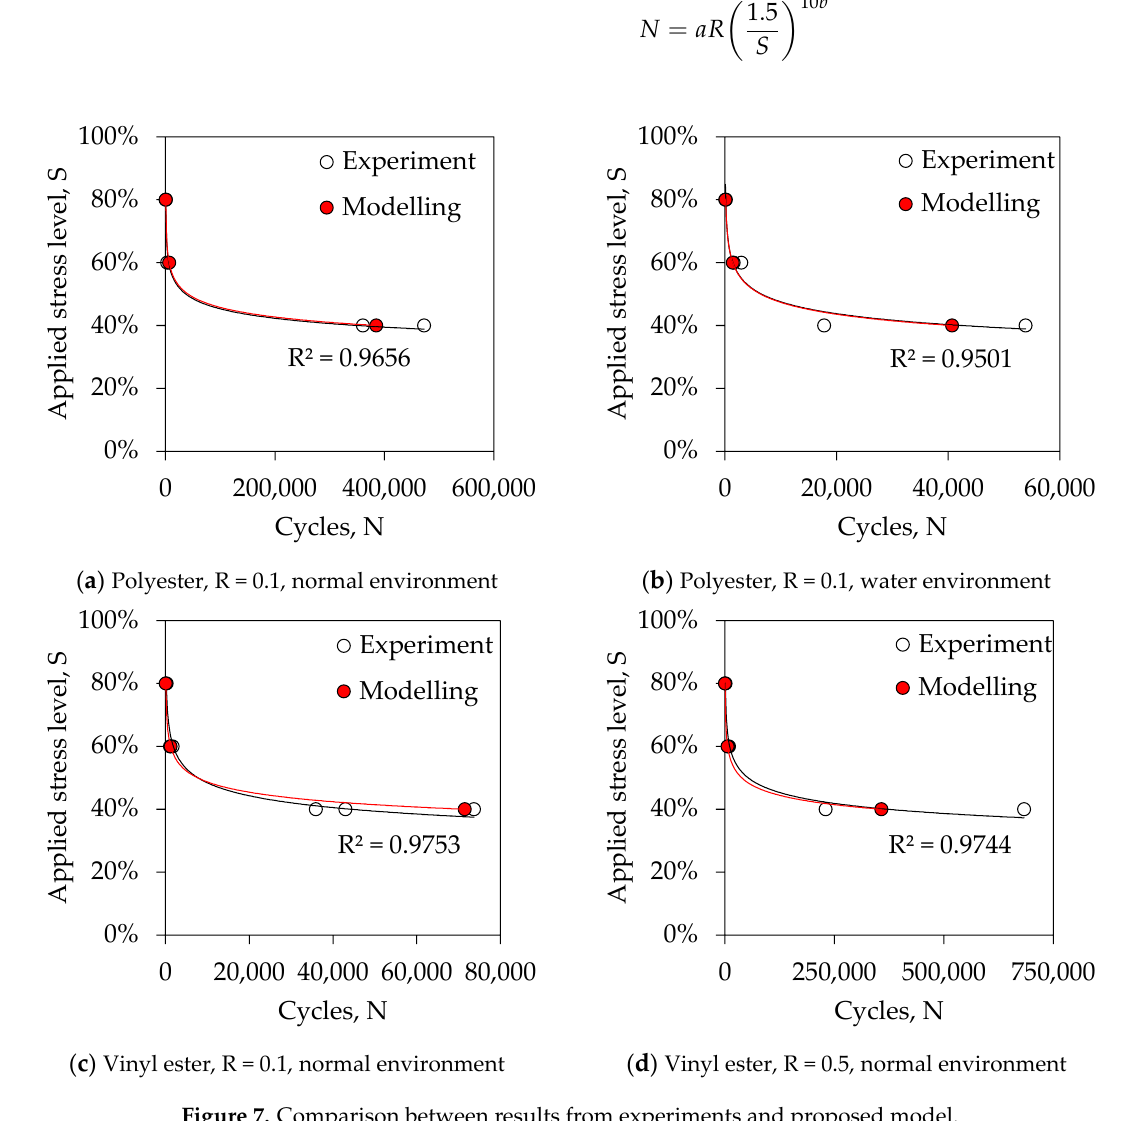
Figure 7. Comparison between results from experiments and proposed model.